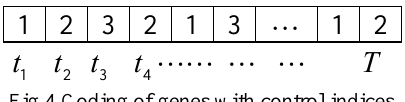
Fig.6 Rest-to-rest planning us ing VSDM : with obstacles in